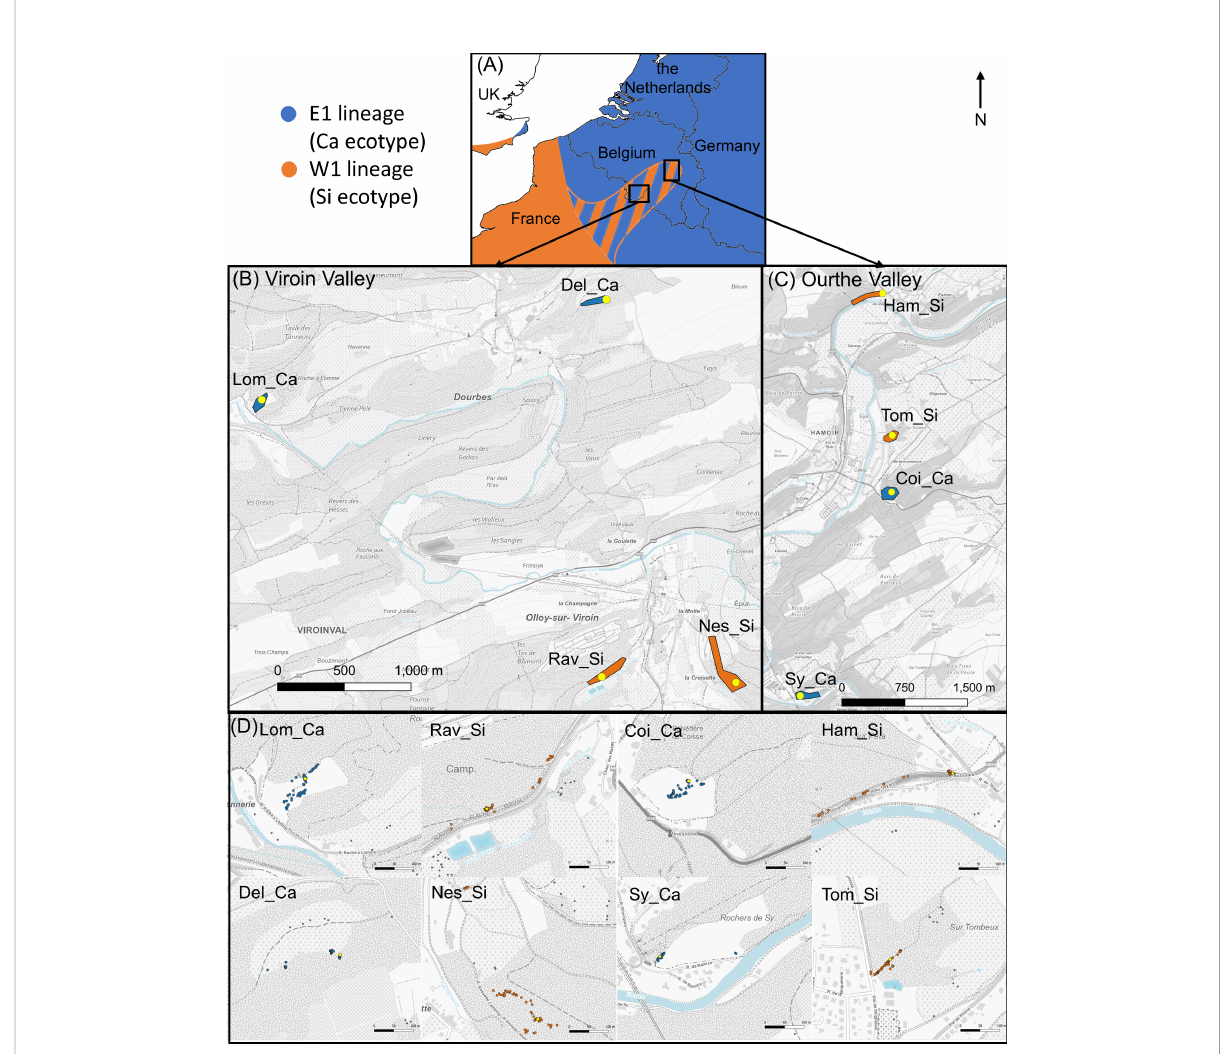
FIGURE 1 Maps showing (A) the general distribution of E1 and W1 genetic lineages of Silene nutans around the area of study, (B, C) the studied populations in southern Belgium (Viroin Valley and Ourthe Valley, respectively), and (D) the individuals studied in each sampled population. Blue and orange dots represent recipient individuals from calcicolous ecotype (E1 lineage) and silicicolous ecotype (W1 lineage), respectively. Yellow dots indicate source individuals. Source of the background maps: Institut Ge ́ ographique National